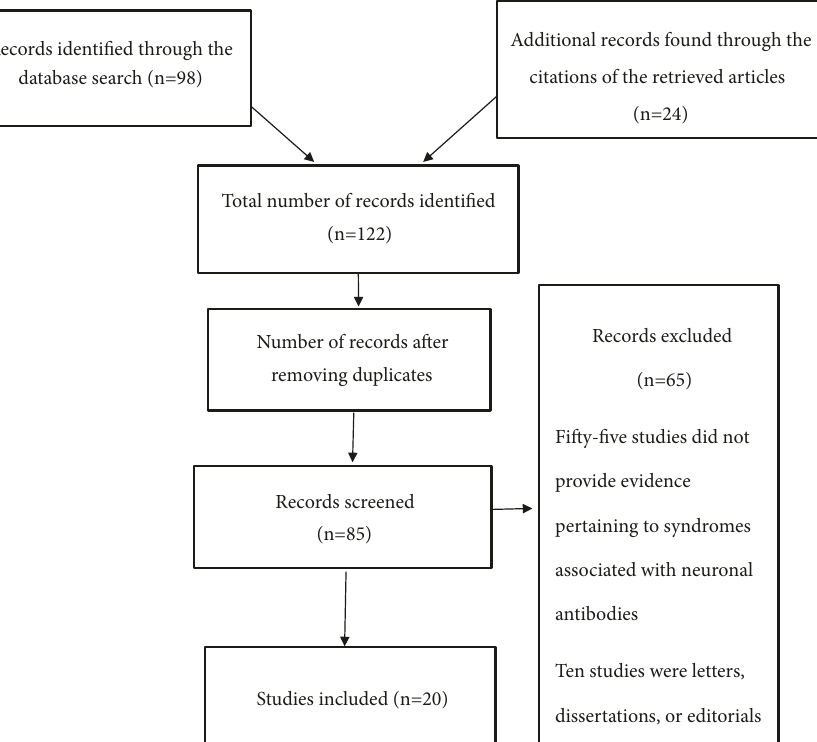
Figure 1: PRISMA flow